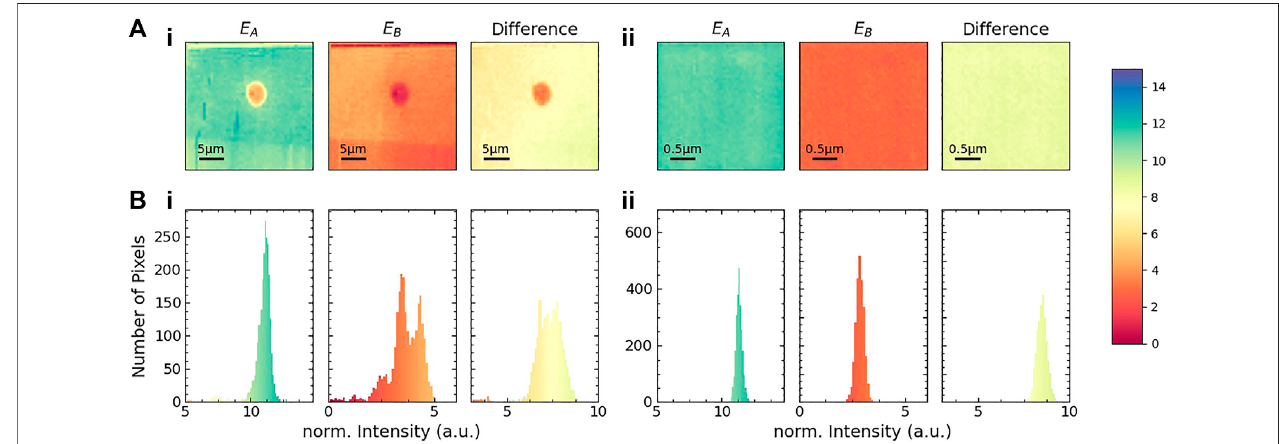
FIGURE 4 | Spatially resolved XAS measurements of the PrNiO 2+ δ thin fi lm. upper row: Image scans at peak A, peak B, and the difference image: A — B for two differentimage,andcorrespondingpixelsizes.Theimagesontheleft(right)havealateralsizeof25 μ m × 25 μ m(2.5 μ m × 2.5 μ m).Thiscorrespondstoaresolution, i.e. , pixelsize,of500and50 nm forleftandrightpanels,respectively.Thecolorbarontherightsidegivesthenormalizedintensityforallimagescans. (Bi,Bii) : Histogramsof the images shown in the (Ai, Aii) . For both image sizes, the intensity distribution is centered around the TEY value from the energy scan ( Figure 2 ) of the reduced fi lm. Note thatall scans(image and energyscans) were taken in TEY mode at room temperature.The artifact (dot-likestructure) in the larger images (upperleft) probably results from surface contamination or surface defects, lowering the overall XAS intensity of the underlying sample. We emphasize that this is a region of reduced XAS signal, and can in particular not be identi fi ed as an unreduced patch, which would appear in dark red in the difference image and brighter than the background in the E B